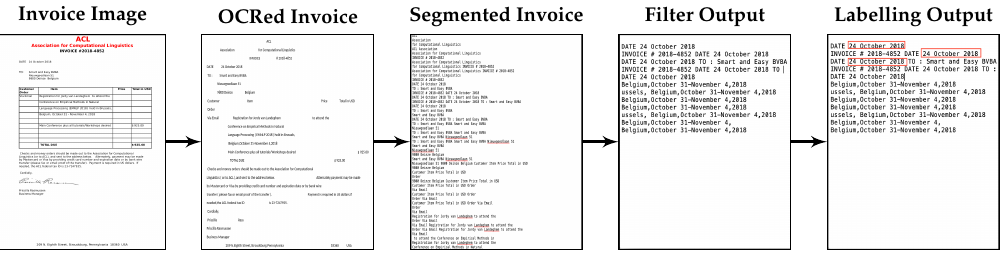
Figure 3. Pipeline for NER in financial documents. Table 1. An example of common entity formats that appear in the invoices.